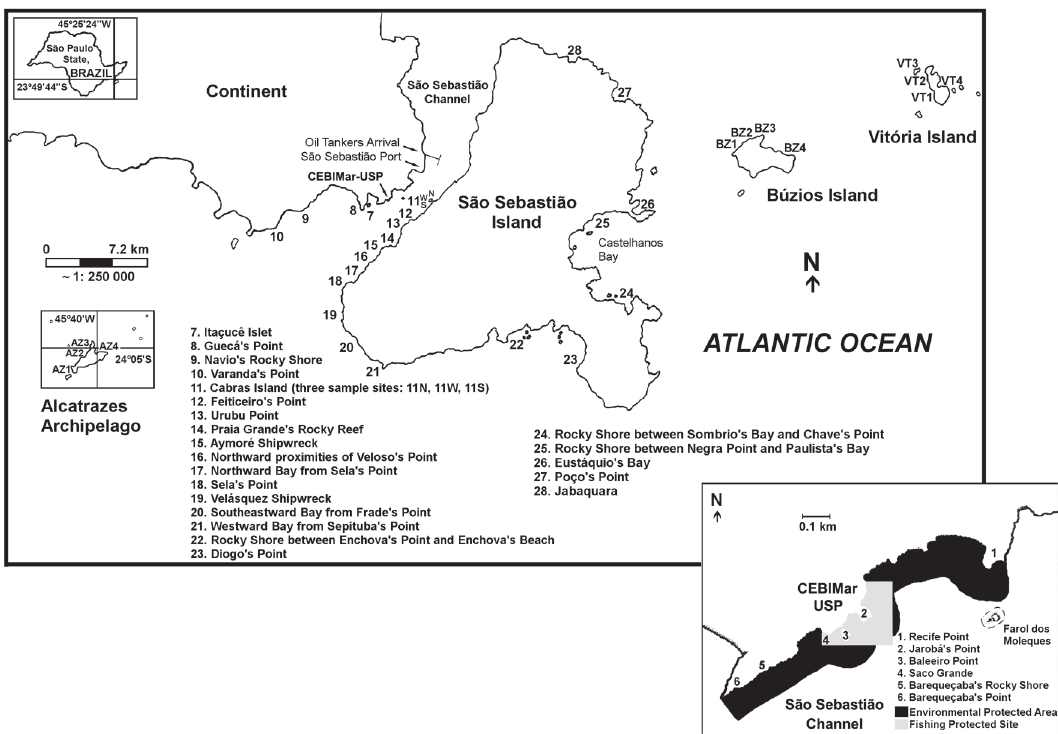
Fig. 1. Study region showing the Channel and the São Sebastião Island, as well as the Alcatrazes, Búzios and Vitória islands. Lower right insert shows the Environmental Protected Area adjacent to the marine station of Centro de Biologia Marinha da Universidade de São Paulo (CEBIMar-USP). Numbers indicate the sites sampled in the Continental Margin of the São Sebastião Channel (1, 2, 3, 4, 5, 6, 7, 8, 9, 10); Insular Margin of the São Sebastião Channel (11N, 11W, 11S, 12, 13, 14, 15, 16, 17, 18), and in the Outer Margin of the São Sebastião Island (19, 20, 21, 22, 23, 24, 25, 26, 27, 28). Sample sites of the three small adjacent islands are coded as AZ1, AZ2, AZ3, AZ4 (for Alcatrazes); BZ1, BZ2, BZ3, BZ4 (for Búzios) and VT1, VT2, VT3, VT4 (for